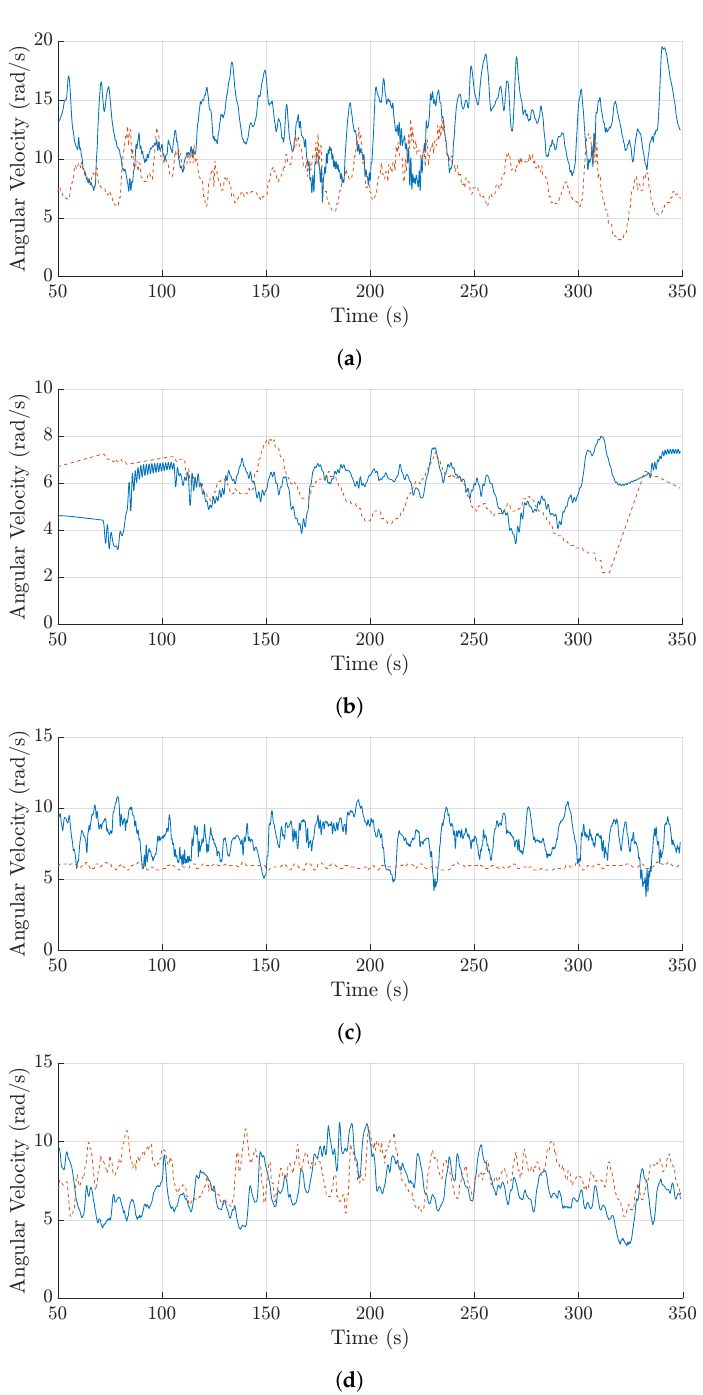
Figure A2. Comparison of the ground station angular velocity between the multi − spring model and experimental data. ( a ) 20 September 2018: rigid wing, TRPT − 3; ( b ) 27 August 2018: rigid wing, TRPT − 3; ( c ) 5 June 2018: soft wing, TRPT − 2; ( d ) 18 June 2017: soft wing, TRPT −